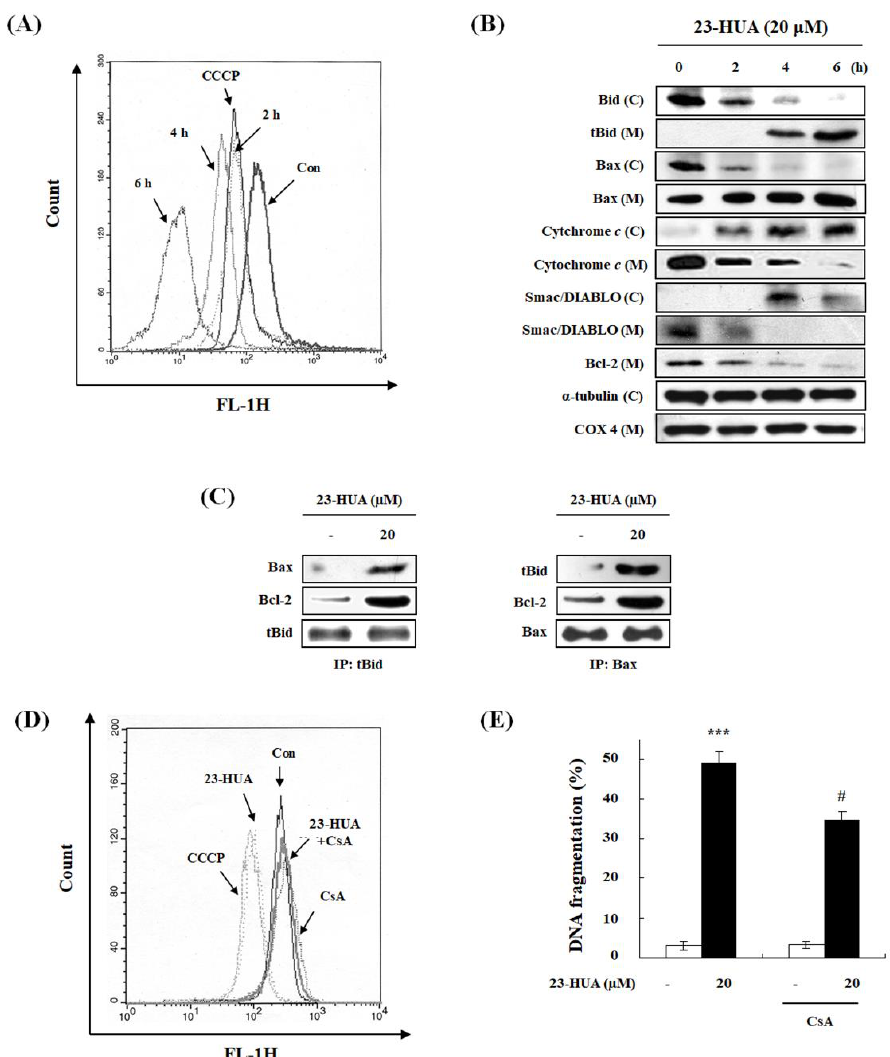
Figure 2. Dissipation of ∆Ψ m and release of pro-apoptotic proteins from mitochondria following 23-HUA-caused apoptosis. ( A ) Analysis of ∆Ψ m after treatment with 20 µ M 23-HUA (0, 2, 4 and 6 h) using CCCP as a positive control. ( B ) Western blot analysis after treatment with 20 µ M 23-HUA (0, 2, 4 and 6 h, C: cytosol, M: mitochondria). α -Tubulin and COX 4 were used as a positive control. ( C ) HL-60 cells were treated with or without 20 µ M 23-HUA for 4 h. Cell lysates were immunoprecipitated with anti-tBid or anti-Bax antibody followed by western blot analysis using anti-tBid, anti Bax, and anti-Bcl-2 antibody (IP: immuonprecipitation). ( D ) HL-60 cells were pre-treated with 5 µ M cyclosporin A (CsA) followed by treatment with 20 µ M 23-HUA for additional 6 h. For analysis of ∆Ψ m , cells were treated with 50 nM DiOC 6 for 30 min. ( E ) DNA fragmentation was detected by DAPI assay. Values are the means ± SD of triplicate experiments. *** p < 0.001 vs. control group, # p <0.05 vs. 23-HUA-treated group.